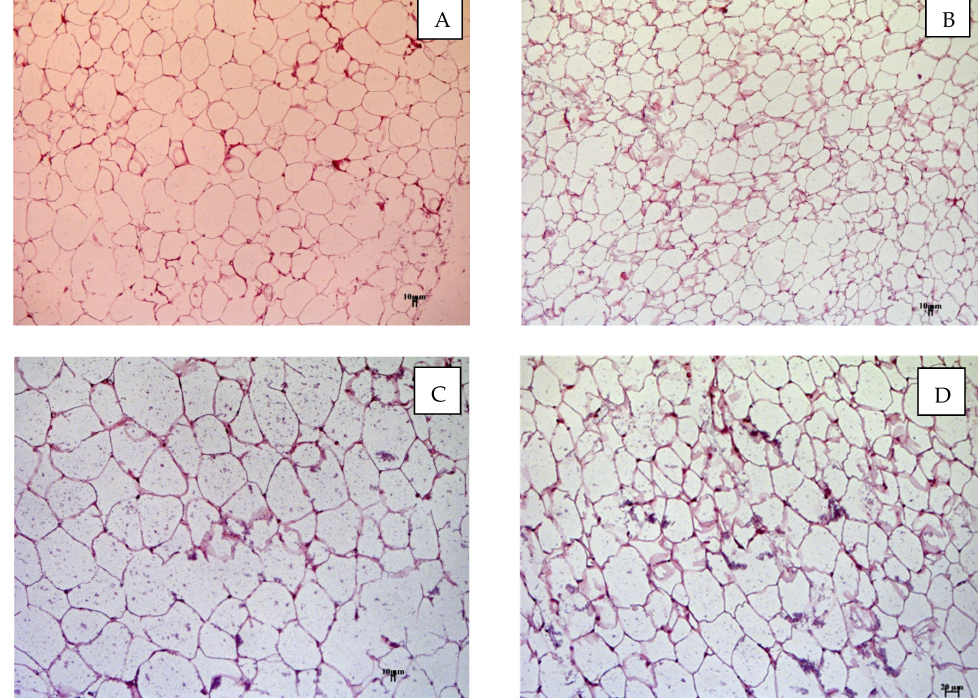
Figure 8. Histological evaluation of white fat in mice after 4 weeks of experiment. ( A ) AY mice (un- treated), ( B ) AY mice treated by metformin at a dose of 250 mg/kg, ( C ) AY mice treated by compound 2e at a dose of 15 mg/kg, ( D ) C57Bl/6 (healthy control). Hematoxylin and eosin staining, × 100.